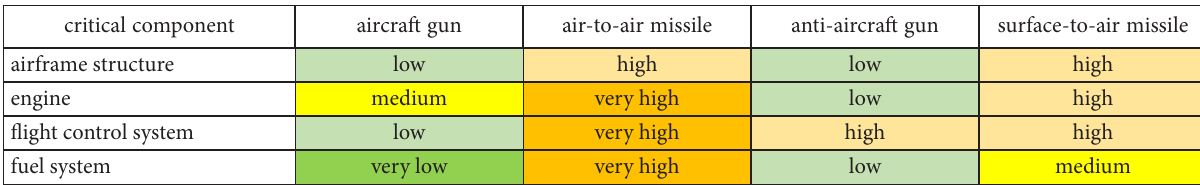
Table 4. Estimation of susceptibility to destruction in combat for MiG-29